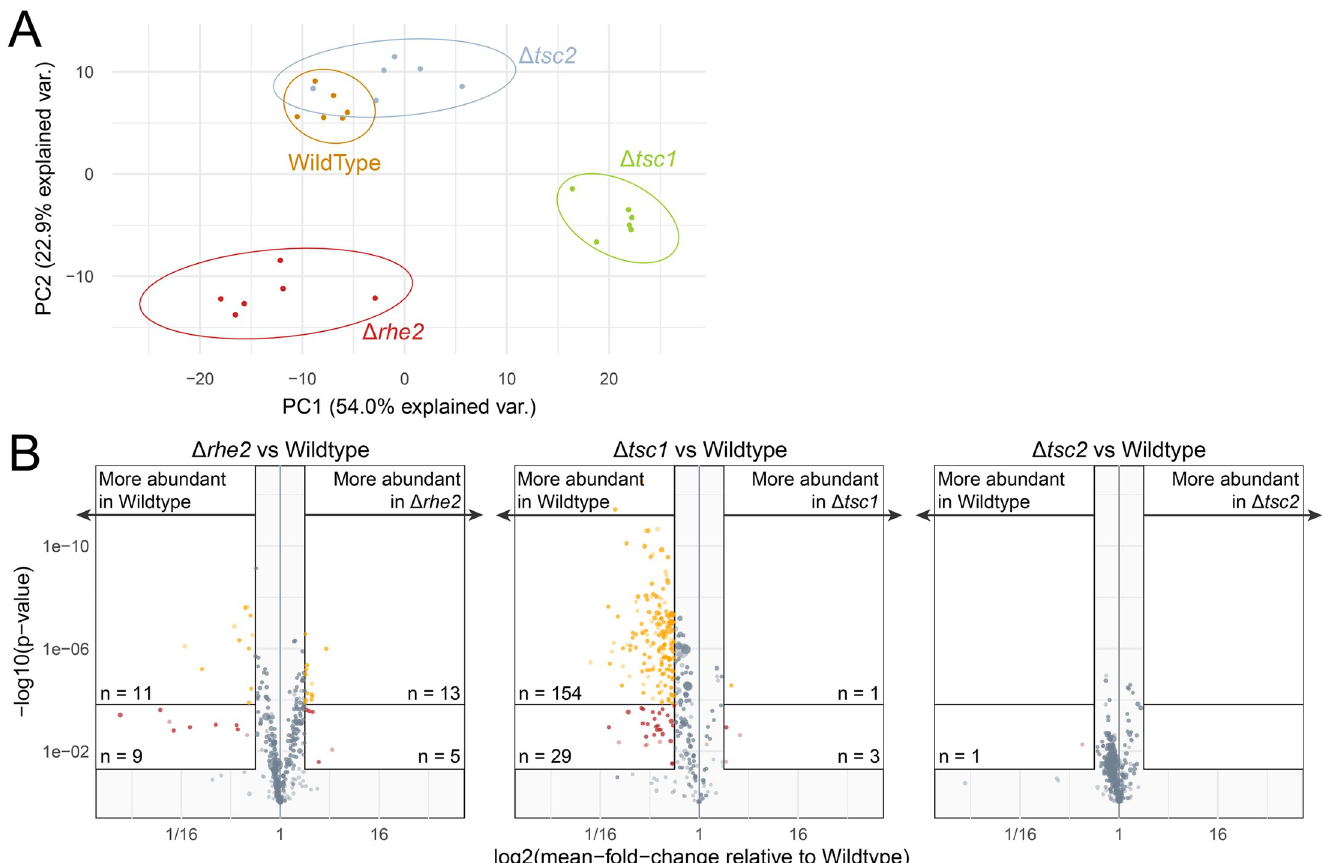
Fig 6. Profiles of low molecular weight substances secreted by T . atroviride Δ rhe2 , Δ tsc1 and Δ tsc2 mutants and the wild type. Fungal strains were grown in six replicates in minimal medium containing either unlabeled or uniformly labeled (NH 4 ) 2 SO 4 and glucose as nitrogen- and sole carbon source respectively. Culture supernatants were harvested after 14 days of growth at 25˚C, analyzed and full scan LC-HRMS chromatograms were processed and filtered for the N-containing submetabolome. (A) Principal component analysis (PCA) scores plot. Clustering of fungal culture samples along PC 1 and PC2 is shown based on the metabolite profiles with 338 N-containing compounds. Ellipses depict the 95% confidence intervals. While samples of the Δ tsc1 and Δ rhe2 mutant are clearly separated from each other and the wild type, the Δ tsc2 mutant samples largely overlap with those of the wild type. (B) Volcano plots illustrating pairwise univariate comparisons of the three mutant strains Δ rhe2 (left), Δ tsc1 (middle) and Δ tsc2 (right) versus the T . atroviride wild type based on their N-containing submetabolomes. Red dots indicate significantly (p < 0.05, FC � 2), those in yellow indicate highly significantly (p < 0.00015, FC � 2) differing metabolite abundances, while grey dots indicate not significantly different